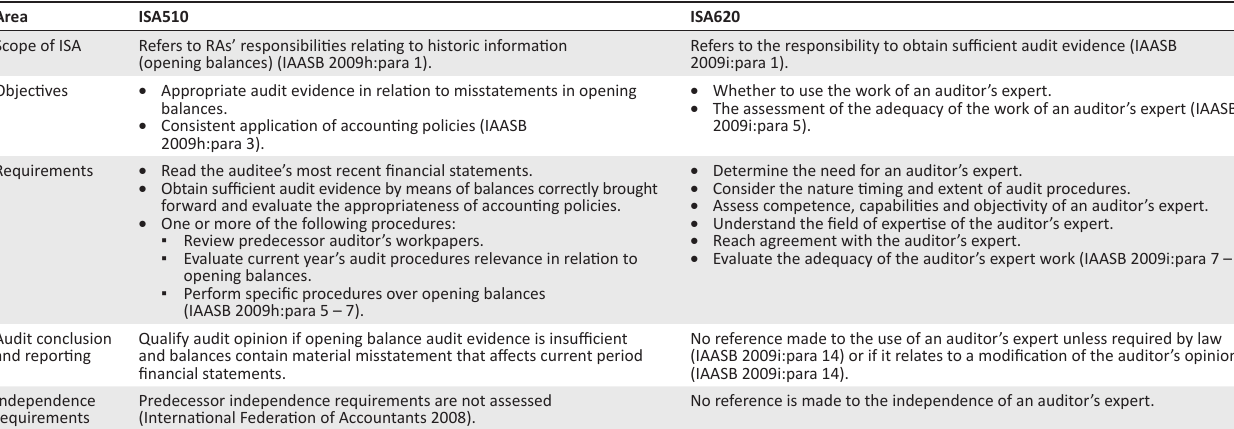
TABLE 1 : Comparison of ISA510 and